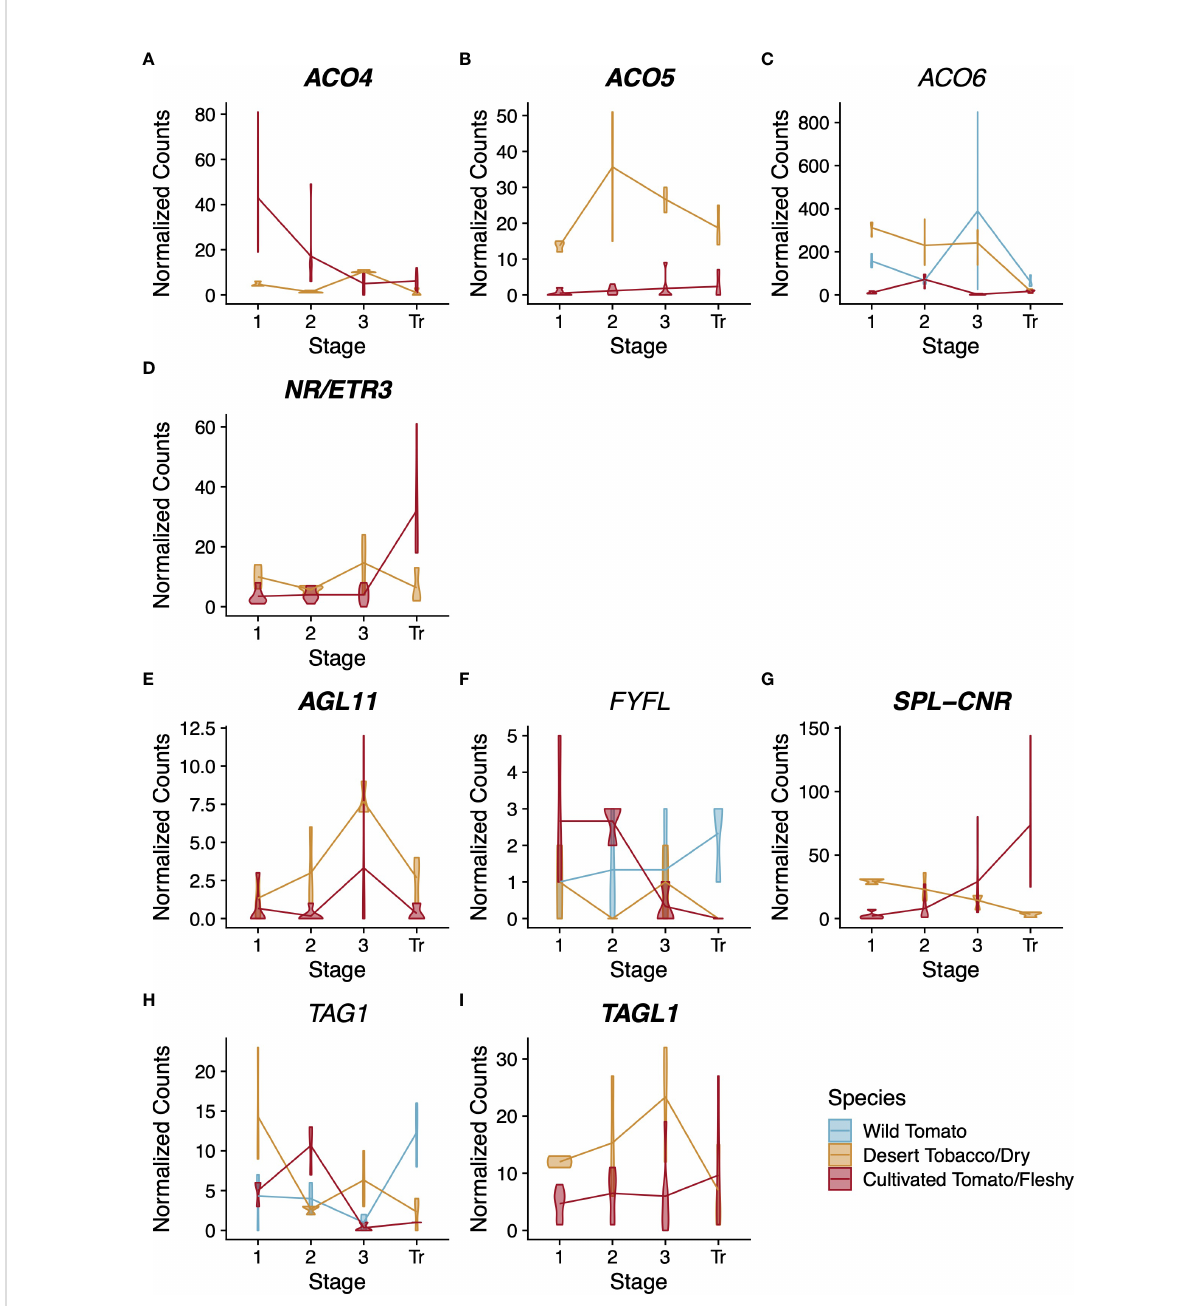
FIGURE 5 Expression pro fi les for ethylene-related (A – D) and regulatory (E – I) genes across the three solanaceous species. Normalised counts of gene expression are represented by violin plots. Genes with statistically signi fi cant (FDR<0.01) differential expression across stages are shown in bold. Dry-fruited desert tobacco values are shown in yellow. When the expression pattern is better described by individual species trends (based on a likelihood ratio test), wild tomato violin plots are shown in blue and cultivated tomato plots in red, otherwise both tomato species are shown together in red. Stages of fruit development on the X-axis are numbered sequentially followed by “ Tr ” for transition to maturity stage. Note that panels have independent Y-axis to maximise